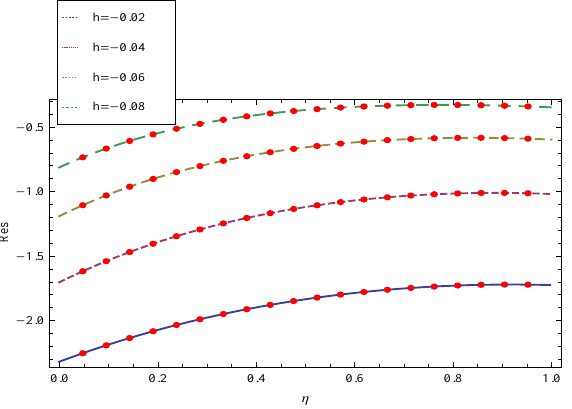
Figure 30. Indicates h curves of the residuals for the temperature profile θ ( η ) , when λ = 0.6, S = 0.6, Kr = 0.4,Pr = 1,Ec = 0.4,Nb = 0.6,Nt = 0.5,Sc = 0.5, β =